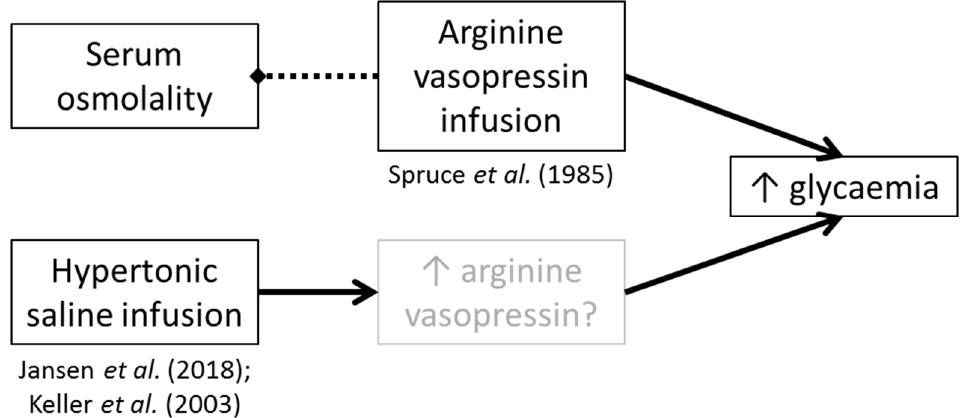
Figure 3. Theoretical relationship between AVP or saline infusion and glucoregulation. Dotted line with diamond arrowhead represents no effect. Greyed out box means unmeasured, but theoretically on the pathway.